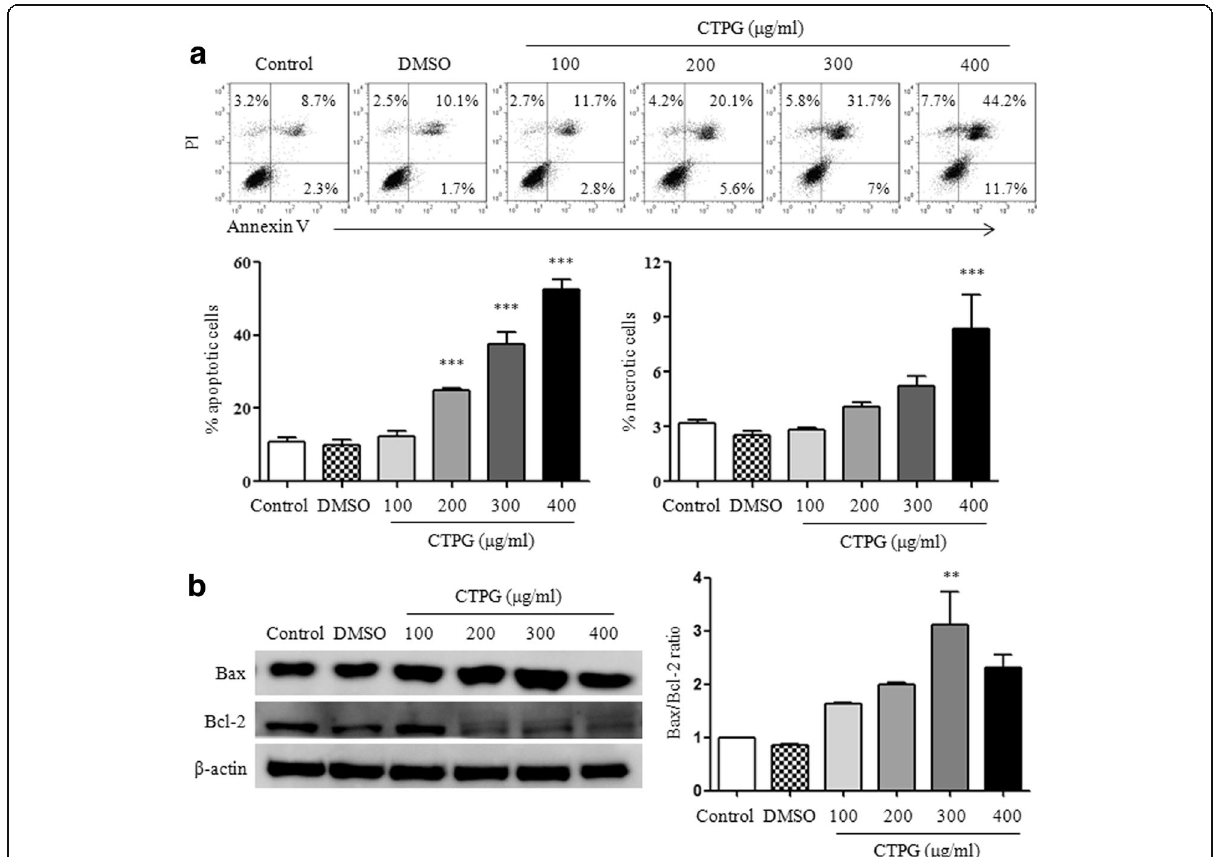
Fig. 2 CTPG induced apoptosis in H22 cells. Cells were treated with different concentrations of CTPG for 24 h. ( a ) The apoptotic and necrotic H22 cells were detected by flow cytometry. The upper panel showed the individual dot plots and the lower panel showed the summary data. ( b ) Total protein was isolated to analyze the expressions of Bax and Bcl-2 by Western blot. ** p < 0.01; *** p < 0.001 compared to